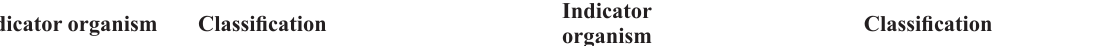
Classification Staphylococcus aureus and Enterococcus faecalis isolated from food samples according to their ability to form biofilm at